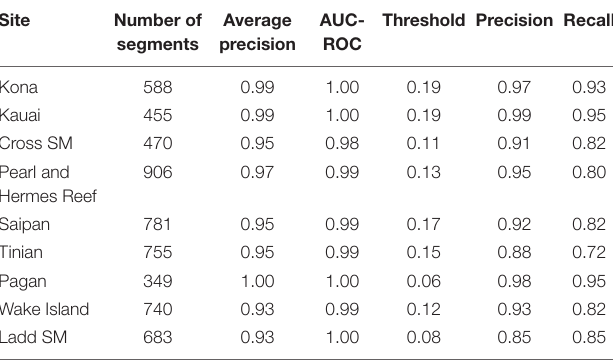
TABLE 2 | Site-specific performance metrics for our model at sites containing humpback